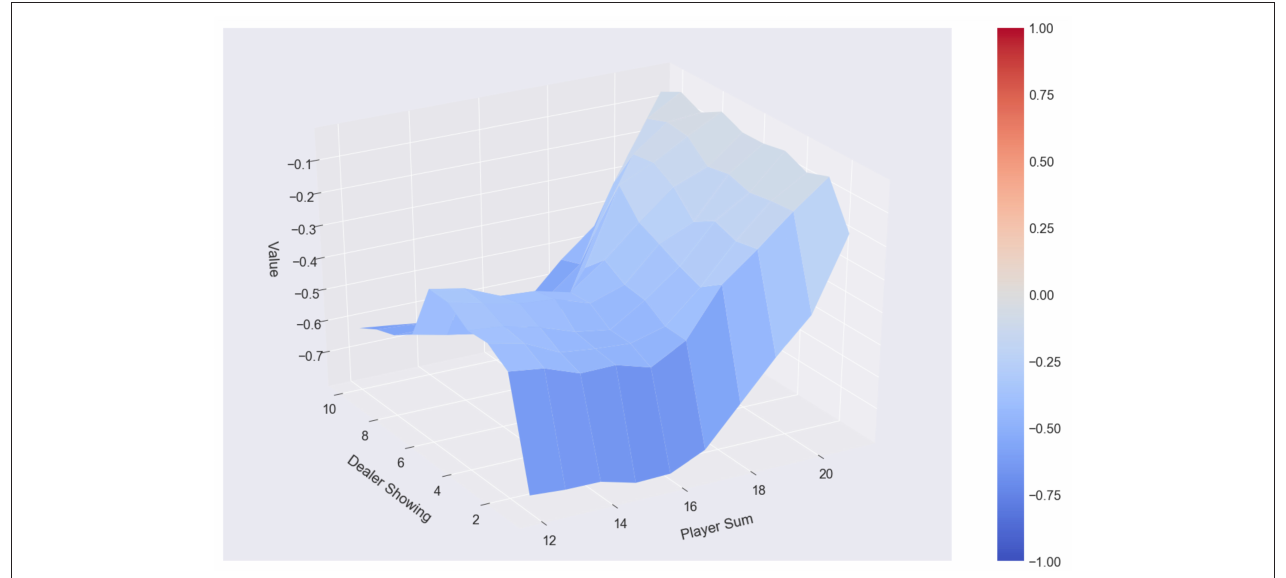
FIGURE 4 | Monte Carlo: 500,000 episodes, policy β , no usable ace.